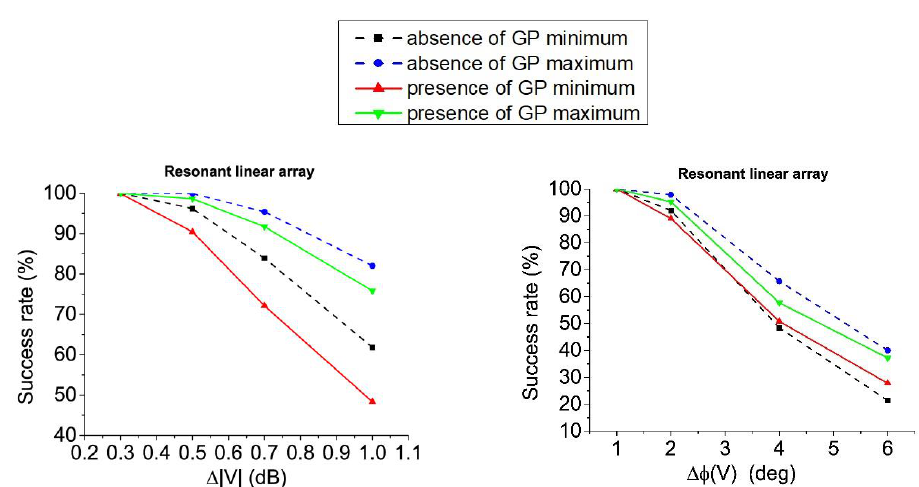
Figure 13. Tolerance to errors of the resonant linear array: Errors in amplitude in absence of ground plane and presence of ground plane ( left ); errors in phase in absence and presence of ground plane ( right ).